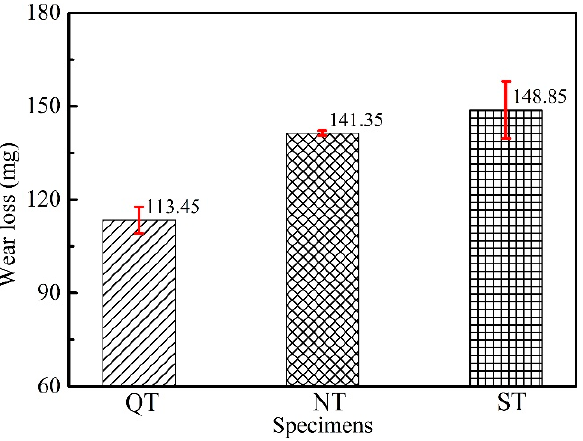
Figure 6. The wear losses of QT, NT, and ST with standard deviations after abrasive wear tests.